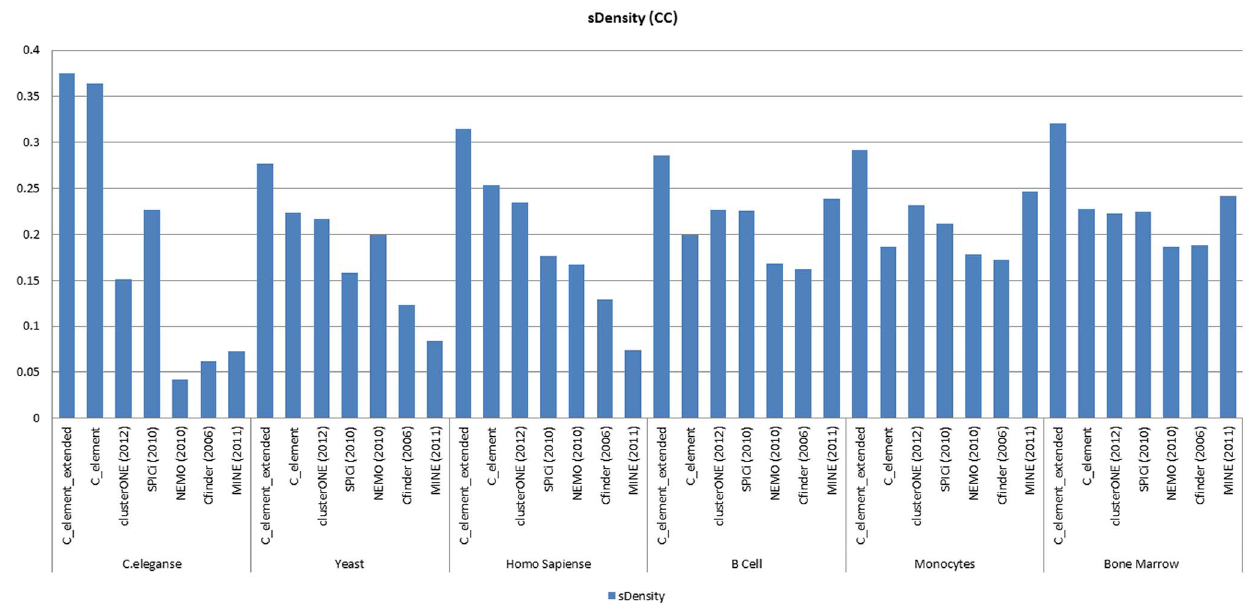
Figure 11. The results of semantic density measure analyses on the results of different algorithms on the six network datasets when GOCC derived functional modules were considered.